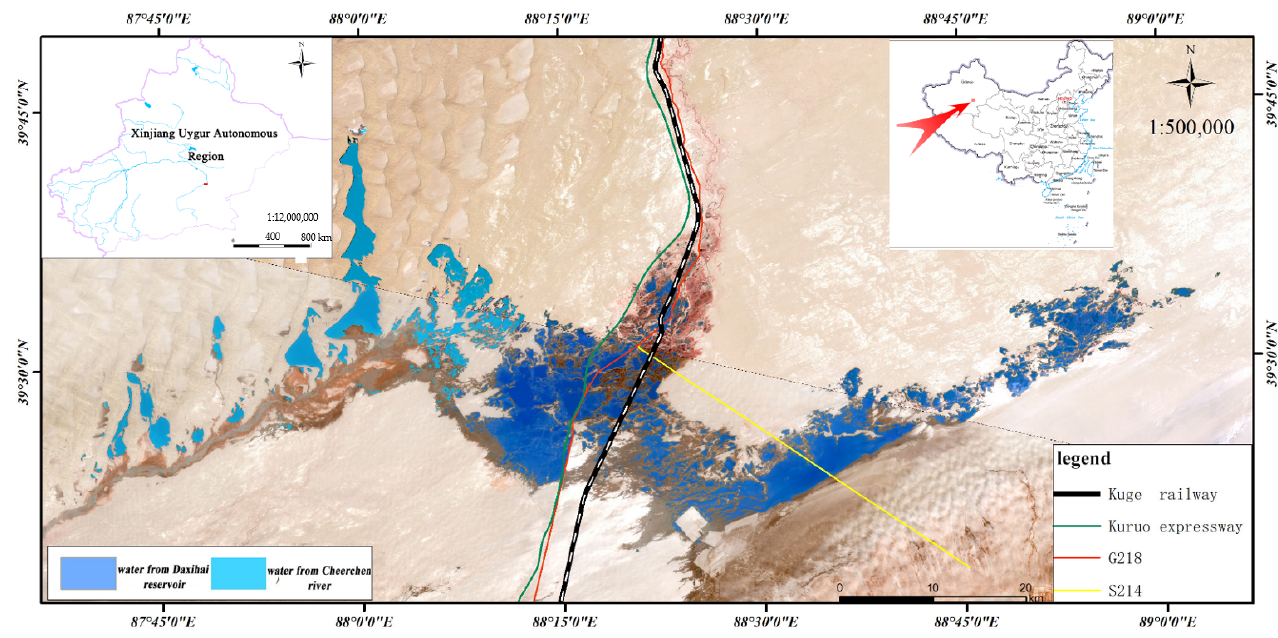
Figure 1. Schematic diagram of the location of Taitema Lake.